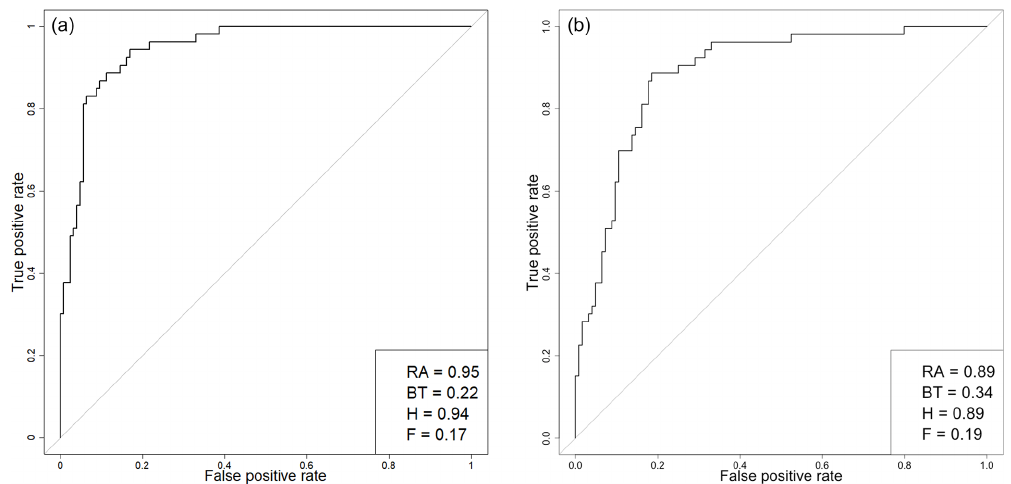
Figure B1. Relative operating characteristic (ROC) diagrams ( a : in-sample validation; b : out-of-sample validation) for above 70th percentile of damage predictions using Eq. (4) for Catalonia ( P 0 = 40mmd − 1 ). Each value of the ROC curves indicates a set of probability forecasts by stepping a decision threshold with 1% probability through the modelling results. The numbers inside the plots are the ROC area (RA) and the best threshold (BT), here defined as the threshold that maximizes the difference between the hit rate ( H ) and the false-alarm rate ( F ).